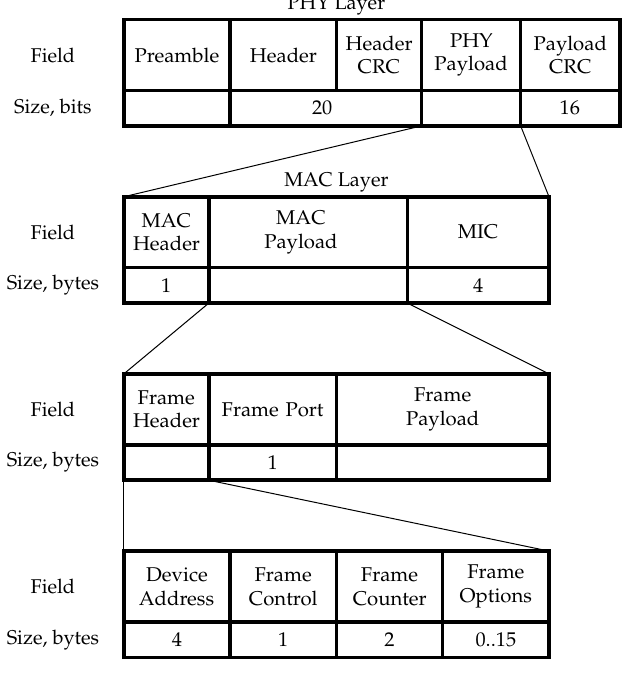
Figure 1. LoRaWAN Frame Format